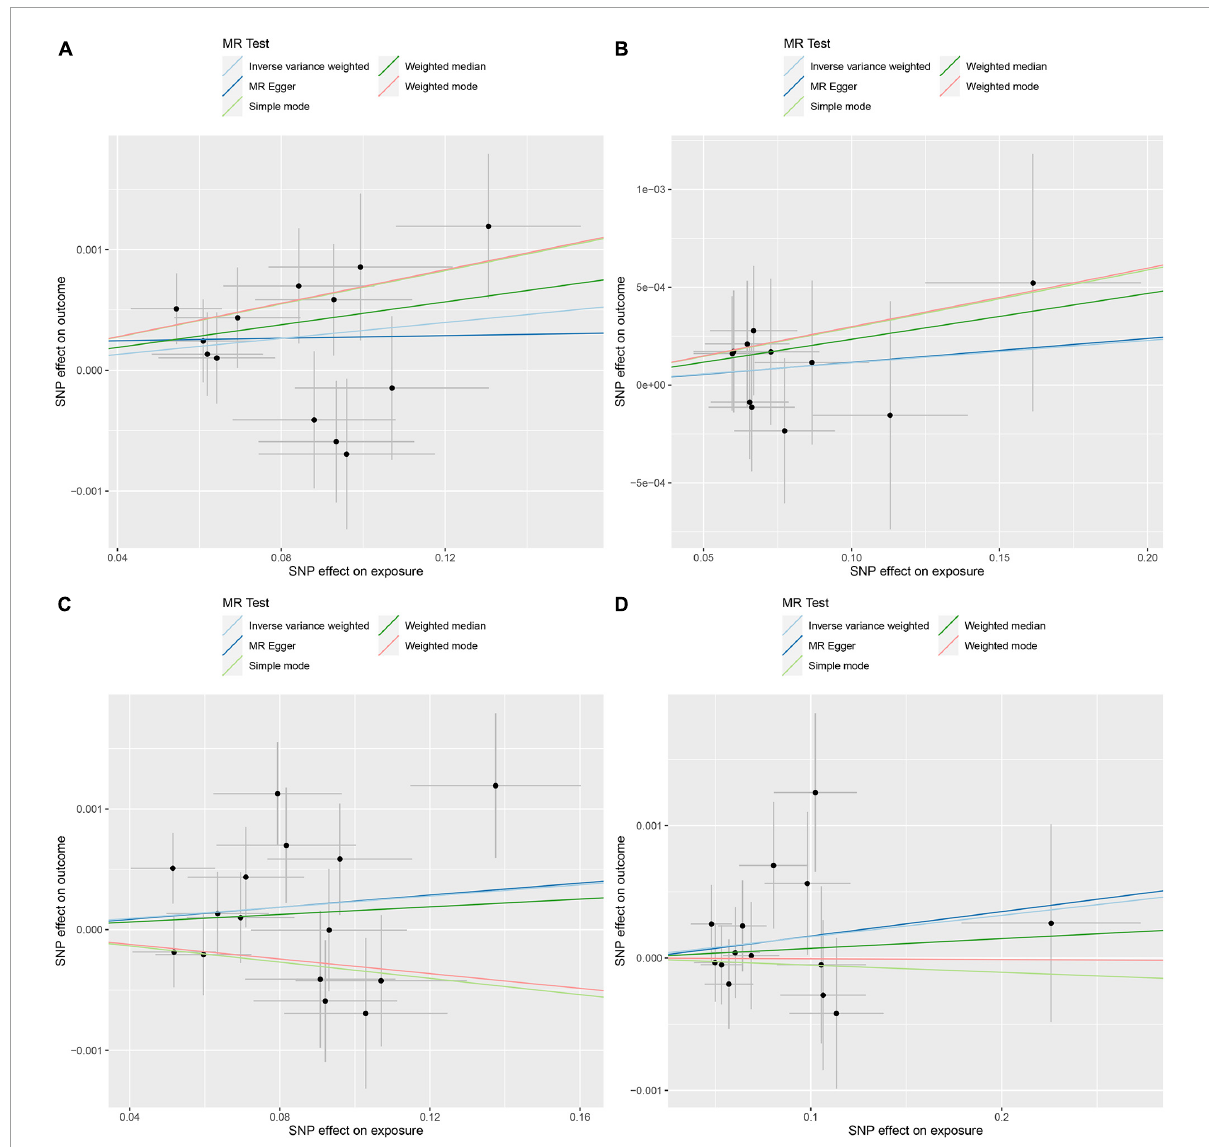
FIGURE3 Mendelian randomization (MR) analysis of the exposures (Streptococcaceae, Dialister, Streptococcus, and Lactobacillales) and outcomes (deep venous thrombosis). (A) Scatter plot of Streptococcaceae and deep venous thrombosis; (B) scatter plot of Dialister and deep venous thrombosis; (C) scatter plot of Streptococcus and deep venous thrombosis; (D) scatter plot of Lactobacillales and deep venous